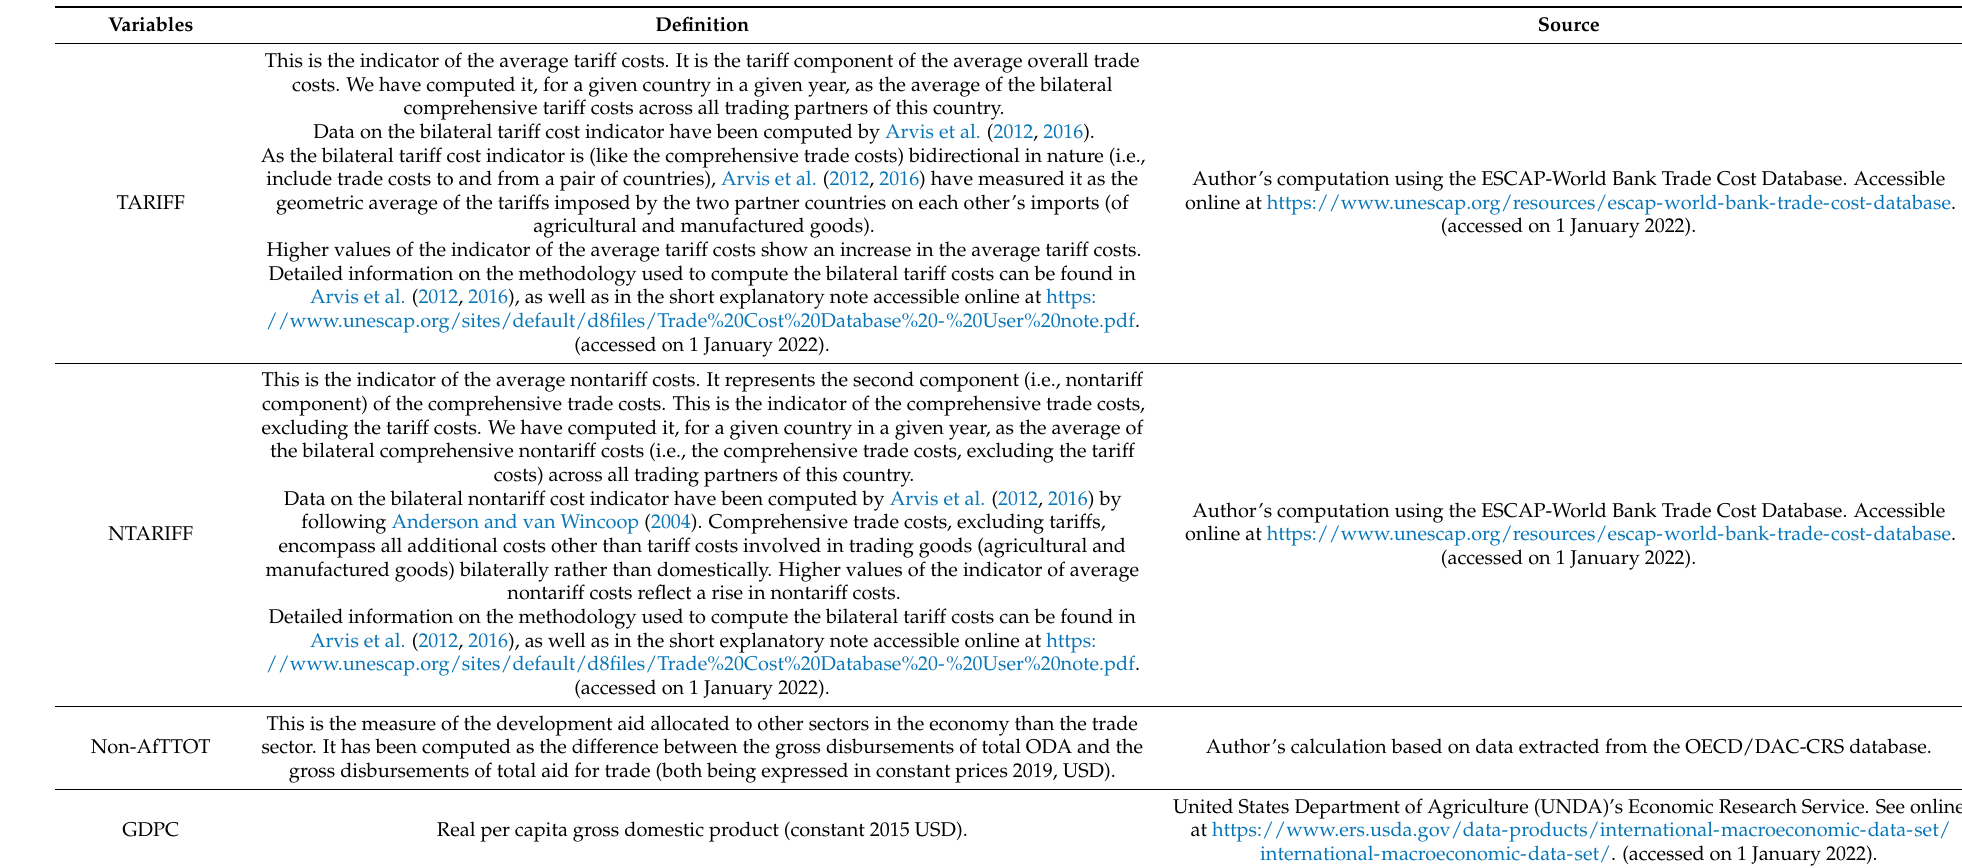
Table A1. Definition and source of